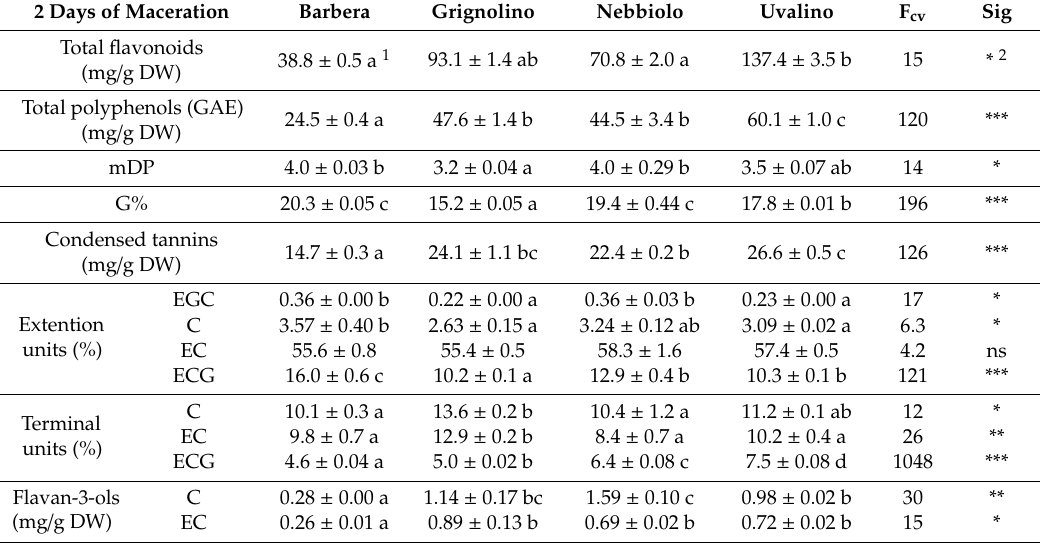
Table 1. Polyphenolic composition of the grape seeds sampled from the fermentation tanks after 2 days of maceration. Analysis of Variance (ANOVA) and Tukey’s test results. mDP = mean degree of polymerization; G% = percentage of galloylation; EGC = ( − )-epigallocatechin; C = ( + )-catechin; EC = ( − )-epicatechin; ECG = ( − )-epicatechin-3- O -gallate. 2 Days of Maceration